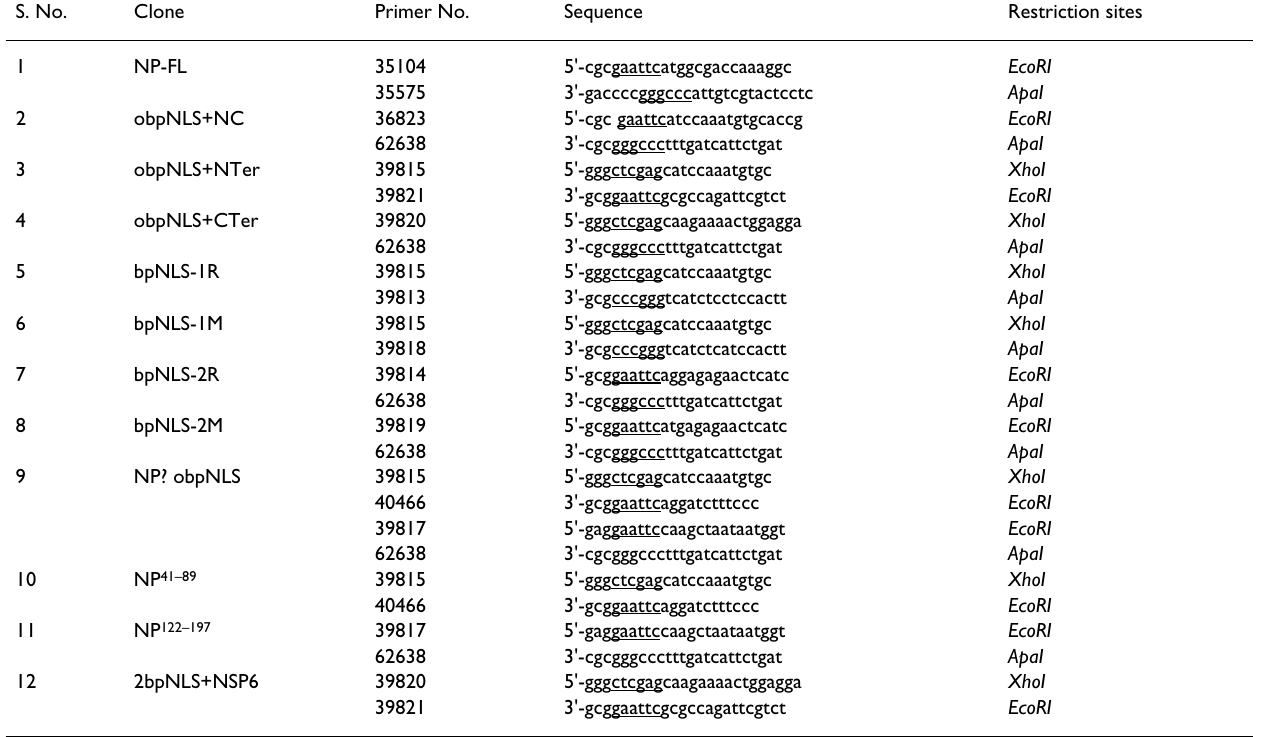
Table 1: Primers used in the study S. No. Clone Primer